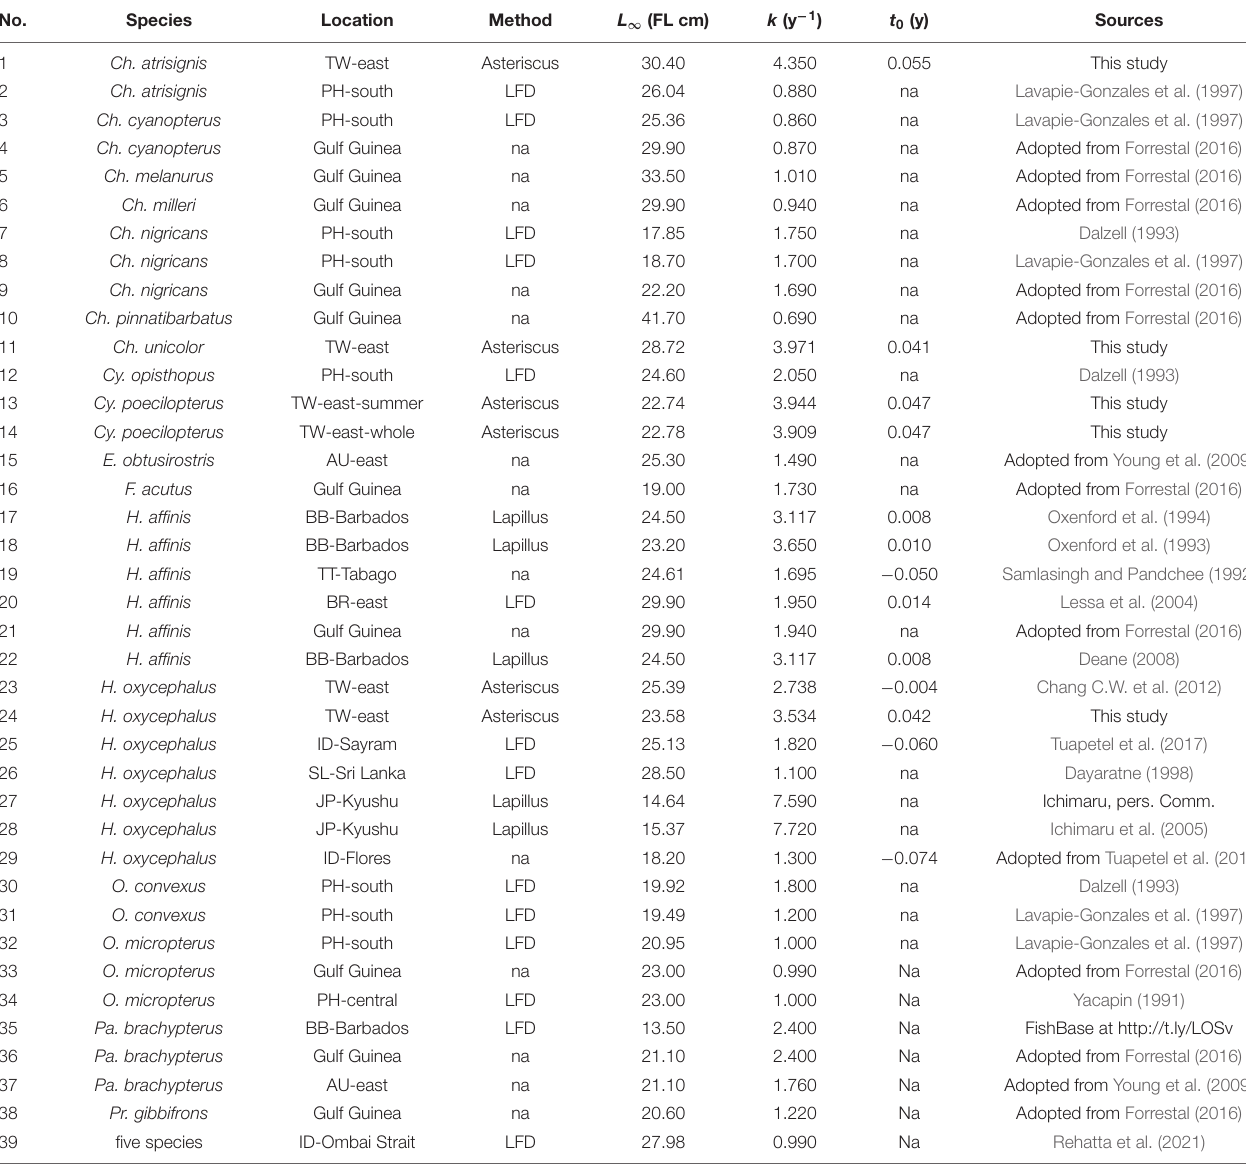
TABLE 2 | Estimates of growth parameters for flyingfishes published globally (in the order of species). Refer to Supplementary Table 1 for detail information.